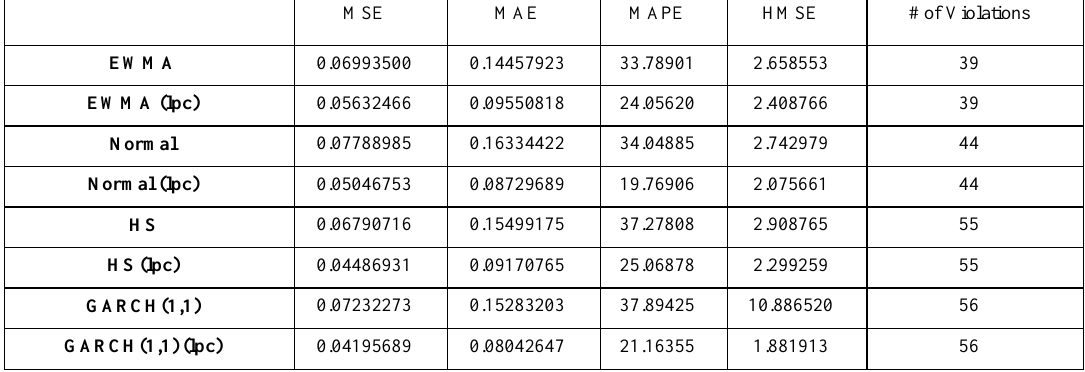
Table 5. Evaluation measures results for PVaR with and without lpc of NBG warrants –